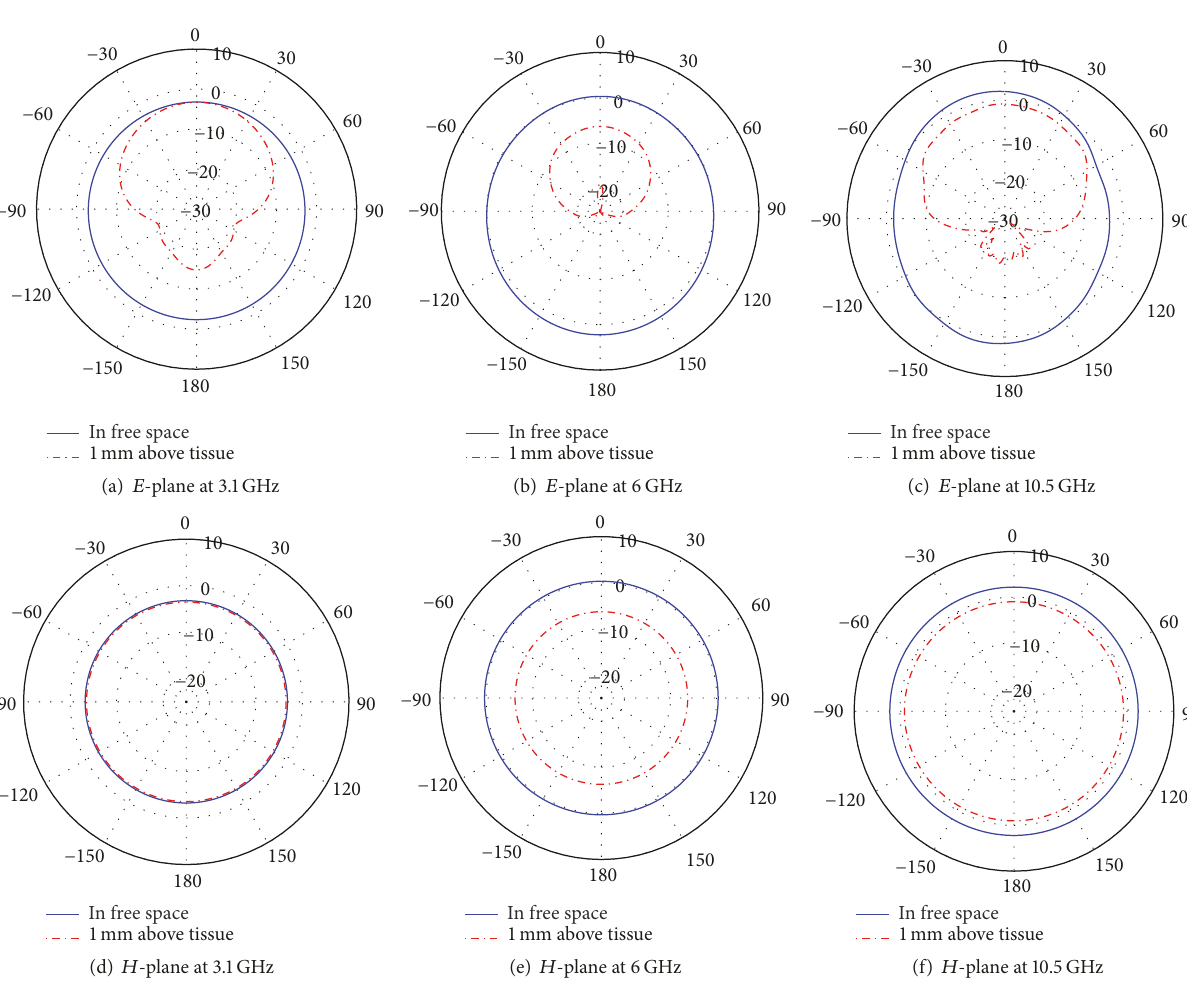
Figure 18: Radiations patterns without and with phantom